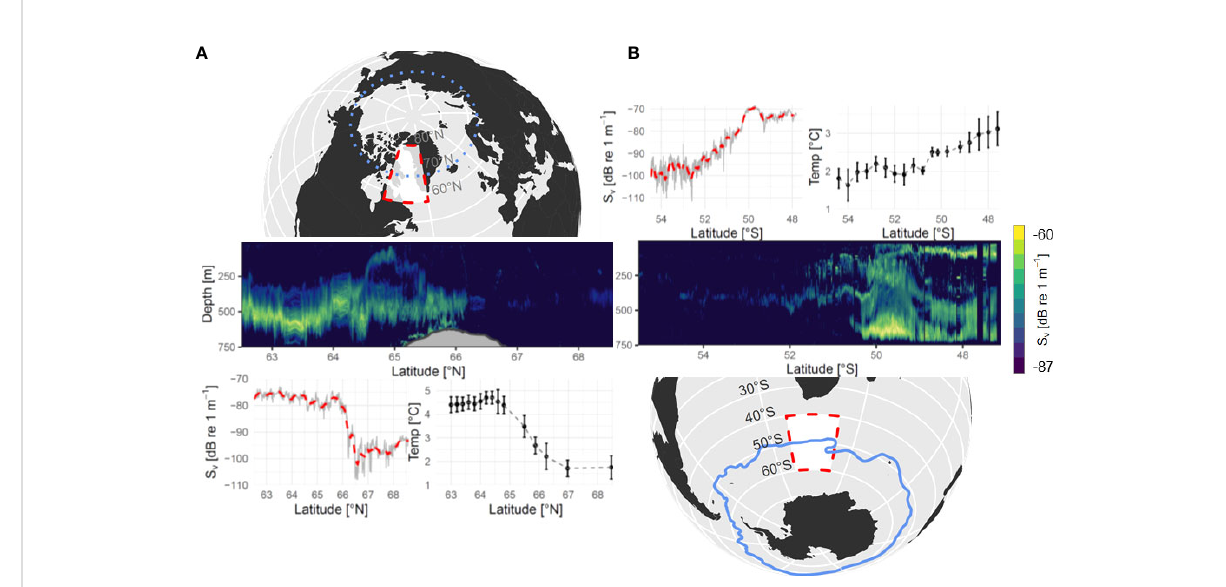
FIGURE 1 38 kHz acoustic backscatter across polar transition zones. Backscatter volume strength (S v , db re 1 m -1 ) collected during a latitudinal transect crossing the Arctic Circle in the Davis Strait (A) and the Antarctic sub-polar current (B) . Echograms display acoustic backscatter calculated for 1 km long x 2.5 m deep intervals. Upper and lower thresholds of -87 to -60 dB were applied to facilitate visualization of the deep-scattering layers. Solid grey and red dashed lines represent S v of upper water column (0-750 m) and a two-sided 25 km moving average, respectively. Temperature panels show mean +/- standard deviation of temperature in the mesopelagic zone (200-1000 m). Dotted blue line in left map panel indicates the position of the Arctic circle and solid blue line in right map panel indicates the Antarctic polar